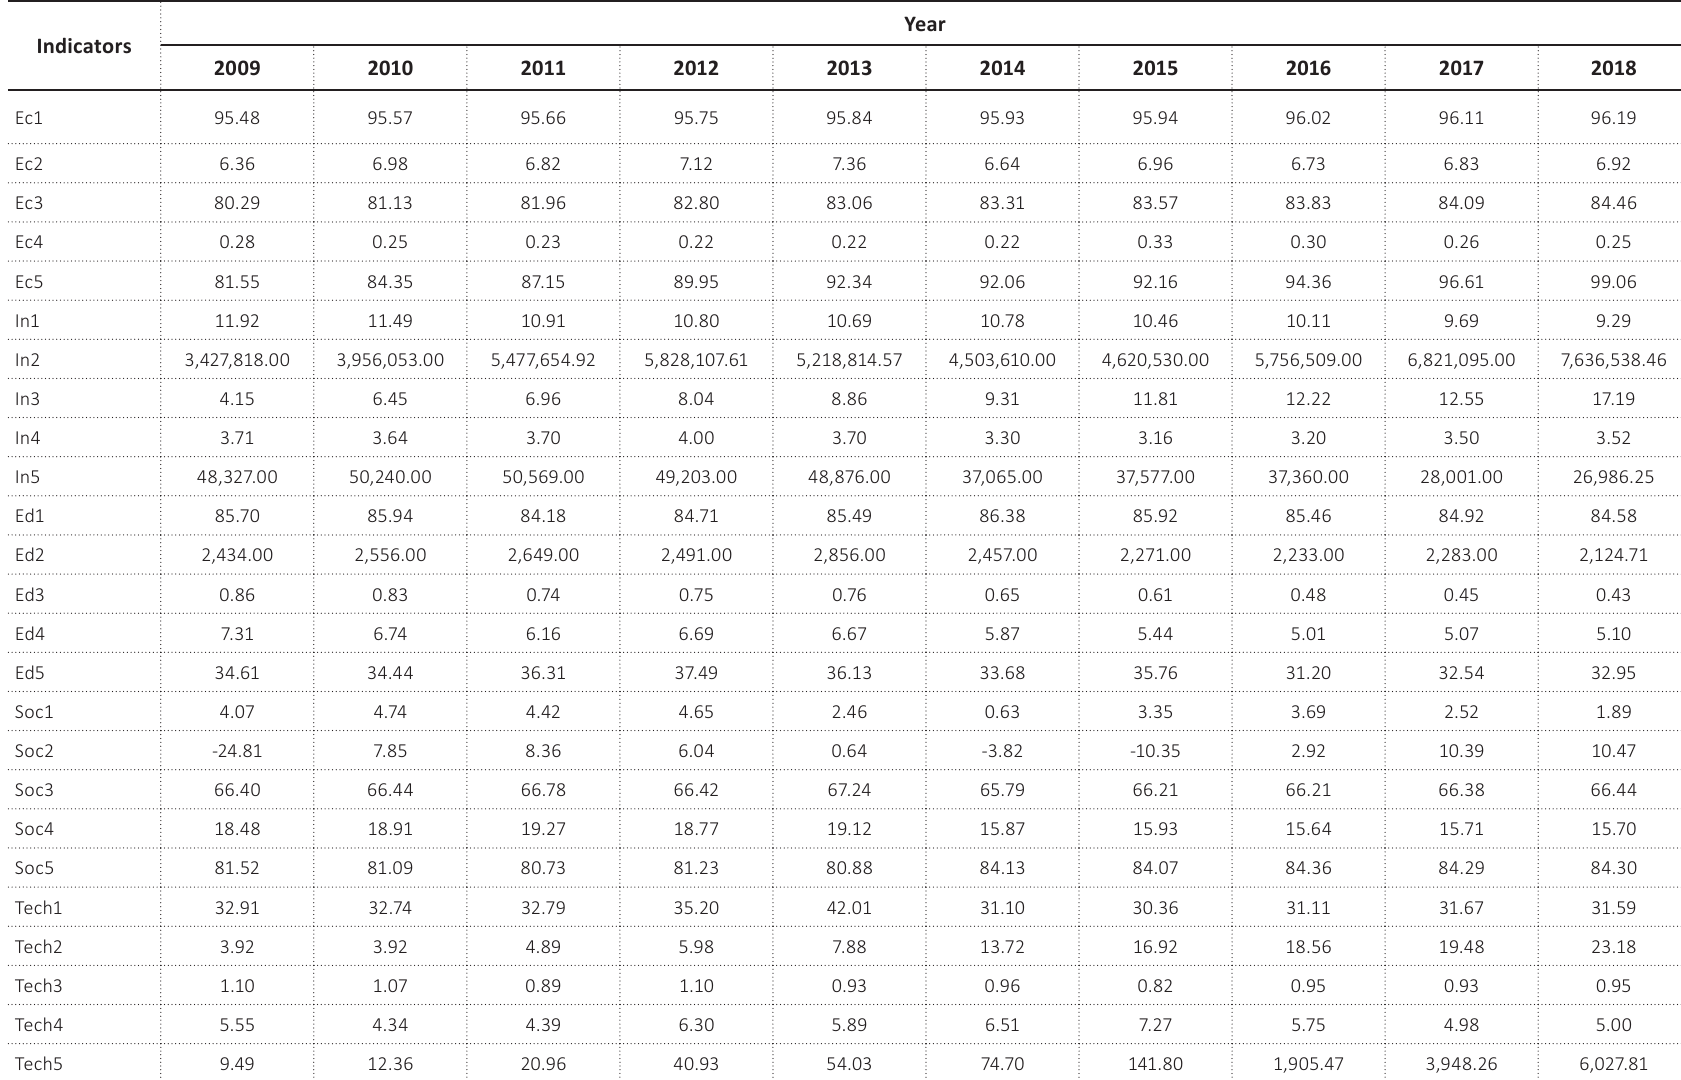
Table A2. Information base for the study of the investment potential of Ukraine in 2009–2018